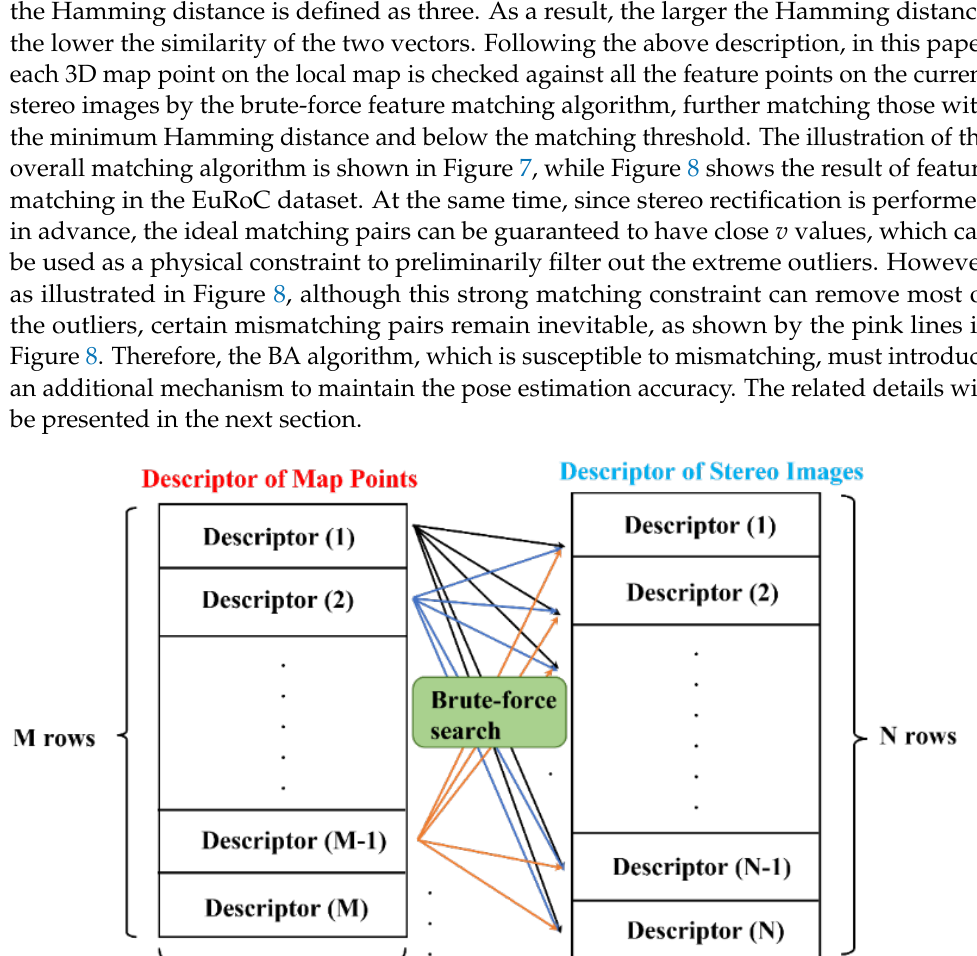
Figure 8. The result of feature matching pairs in the EuRoC dataset. (The left and right image rep- resent the images from the left and right camera of the stereo camera, respectively.) 2.5. Bundle Adjustment Before constructing the BA cost function, the camera model must be established first. The pinhole model is often used to describe the conversion mechanism between the cam- era frame and the pixel frame. The projection can be expressed as: :